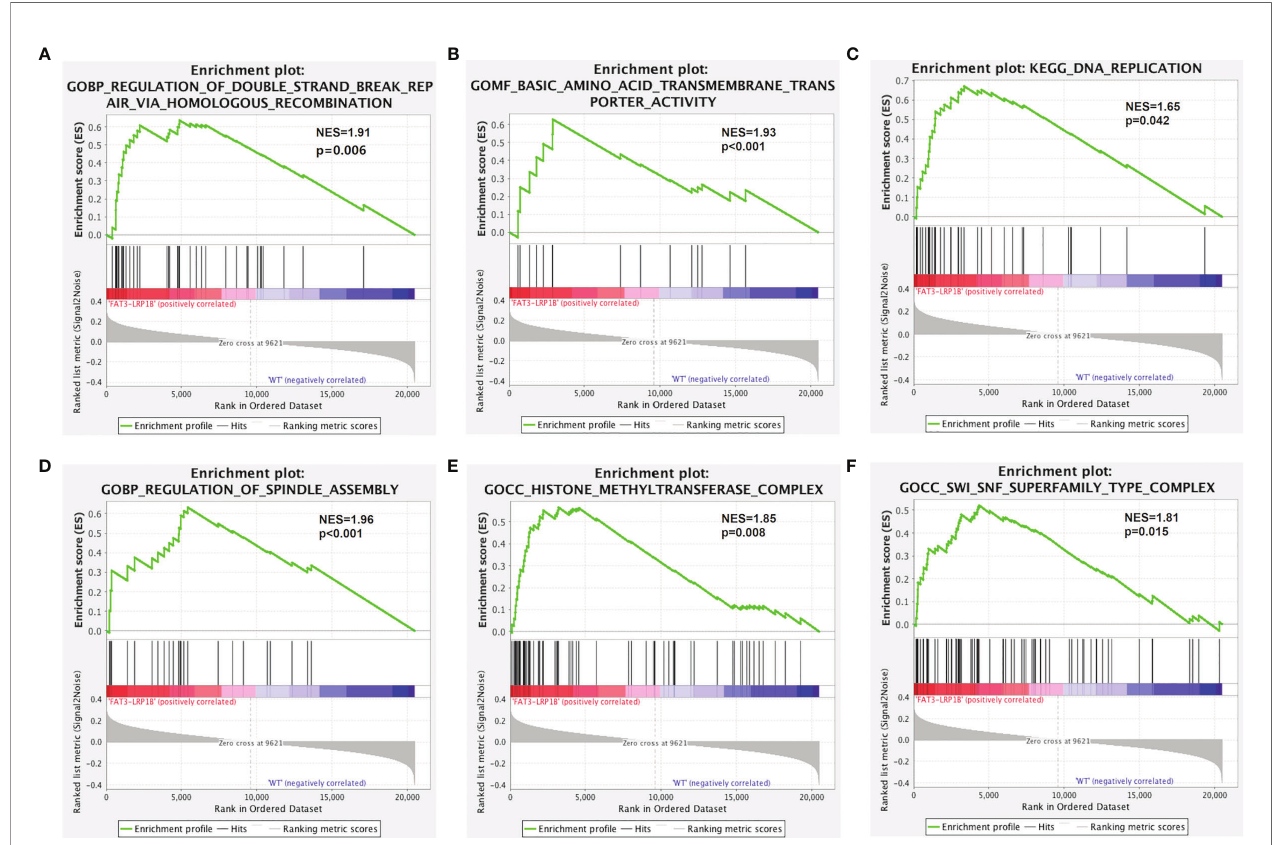
FIGURE 5 | Signi fi cantlyenrichedpathwaysassociated with LUADsamples with co-mutationsofFAT3 and LRP1B. GSEA analysis revealed that the FAT3 + /LRP1B + subgroup signi fi cantlyenriched in (A) Regulation ofdouble strand break repair via homologousrecombination, (B) Basicaminoacid transmembrane transporter activity, (C) DNA replication, (D) Regulation of spindleassembly, (E) Histone methyltransferase complex, (F) SWI/SNFsuperfamily type complex. NES, normalized enrichment